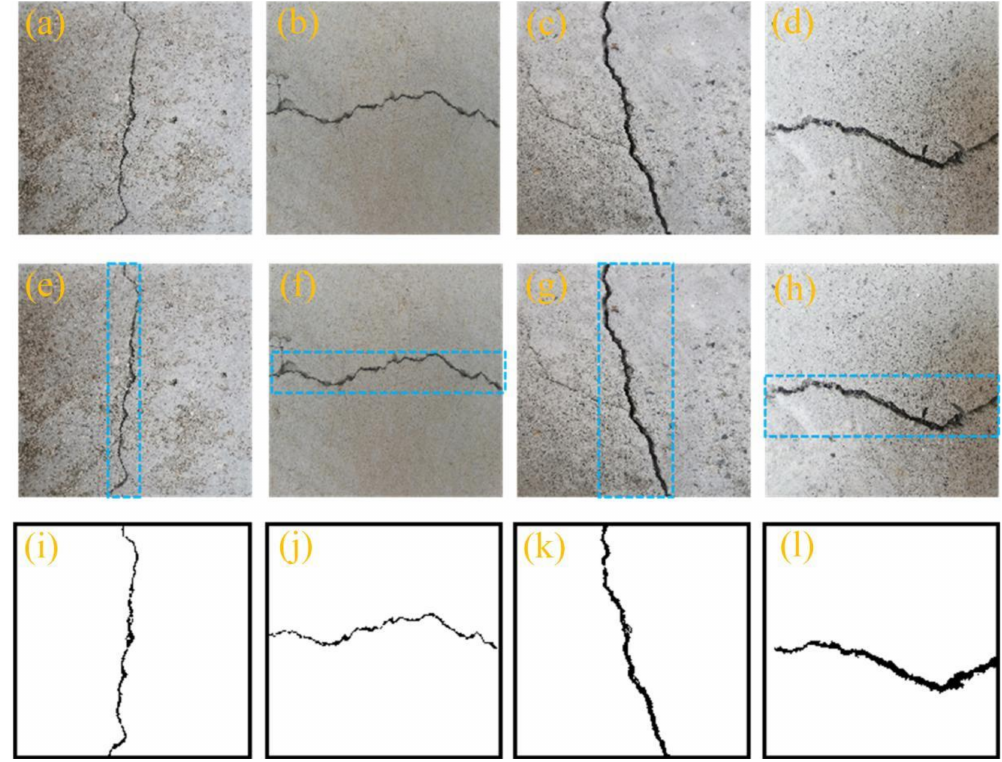
Figure 12. Segmentation process of the proposed method. ( a – d ) are the original images, ( e – h ) are the detection results of cracks, and ( i – l ) are the segmentation results of concrete cracks. In order to verify the applicability of the proposed method, the simple and complex crack images are used for the segmentation by the proposed method. Simultaneously, the brightness of different crack images is also different. For example, some crack images are brighter, some are darker, as shown in Figures 13 and